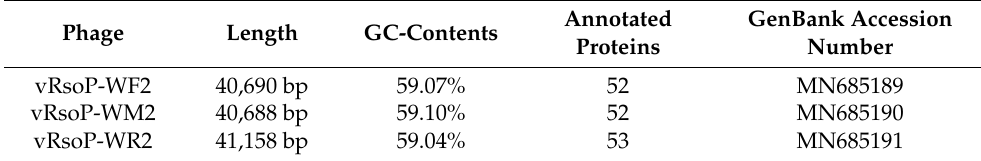
Table 1. Characteristics of the genomes of the three European R. solanacearum phages.